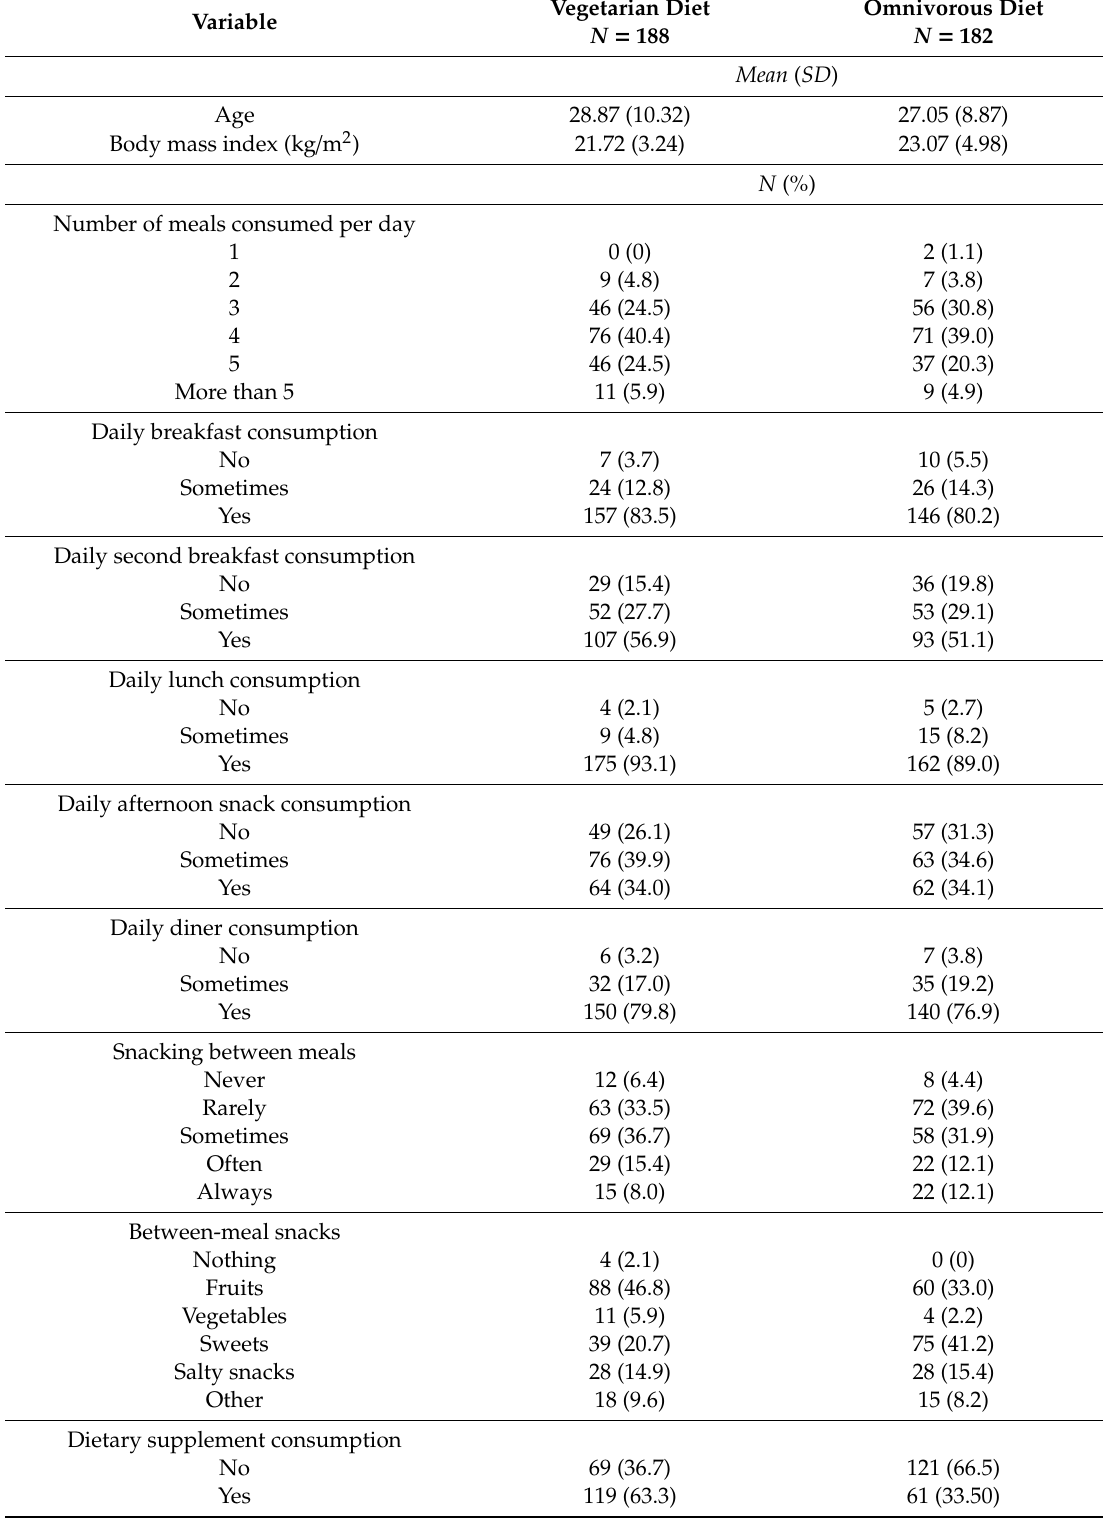
Table 2. Characteristics of the study